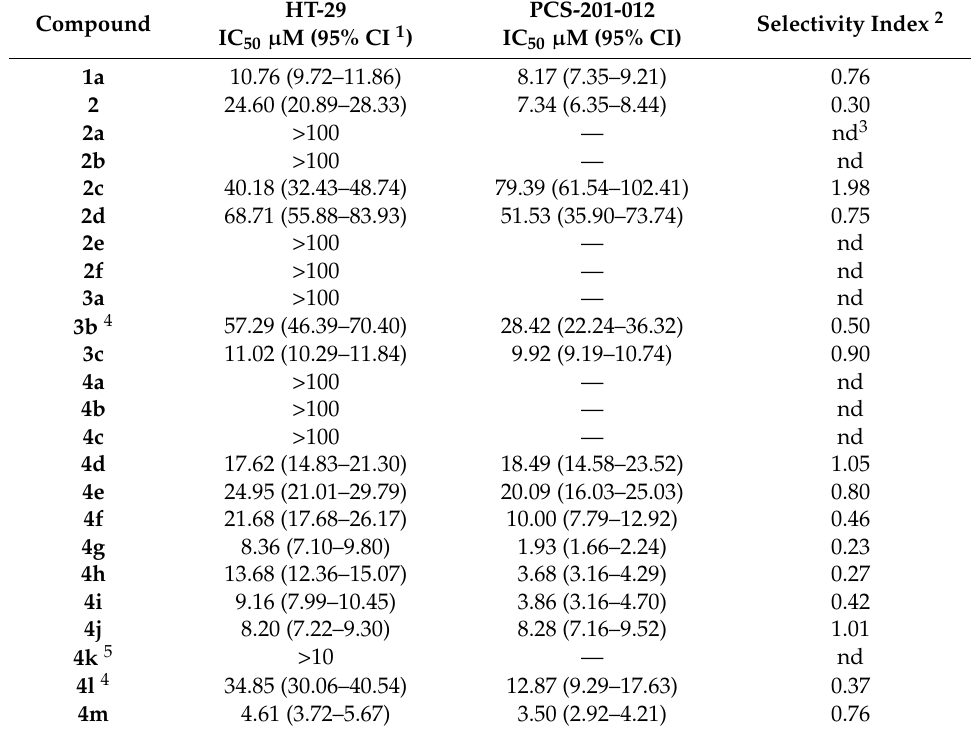
Table 1. Cytotoxic activity of quinone derivatives against HT-29 colorectal cancer cells and fibroblasts PCS-201-012 .